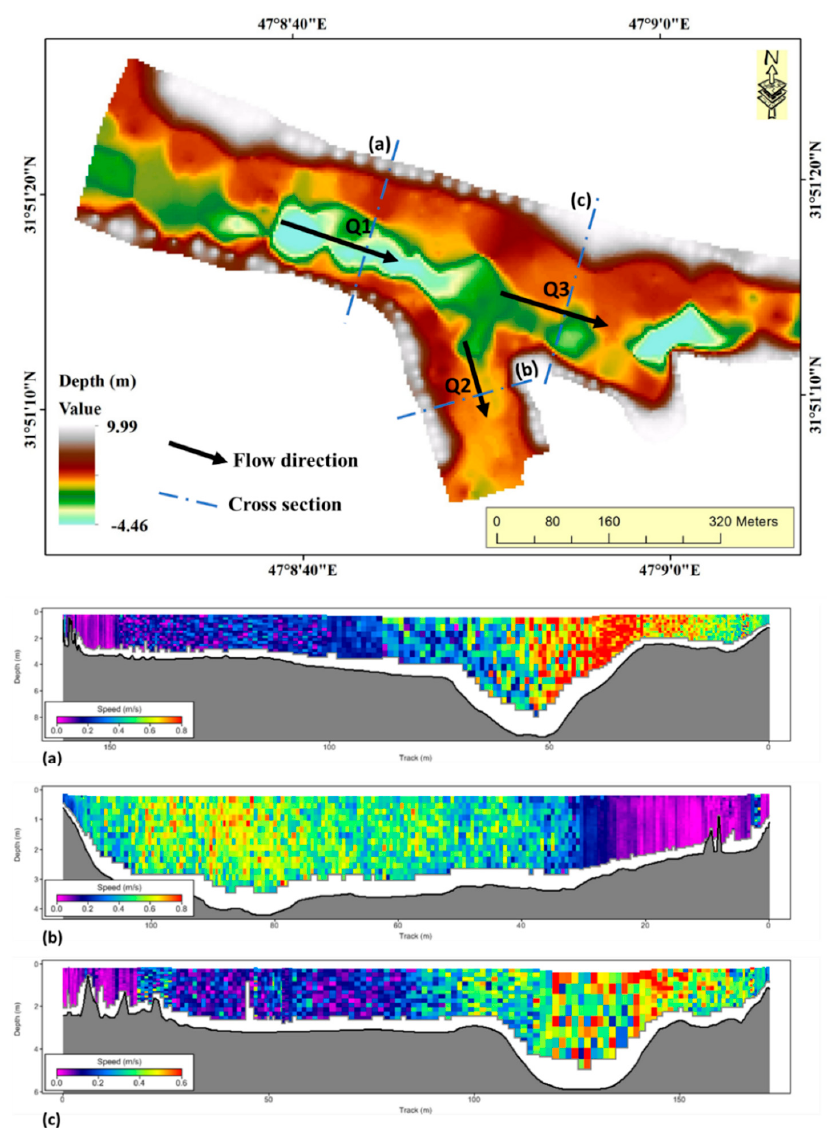
Figure 3. Observed bathymetry survey, with velocity distribution at each reach of the Tigris branching junction, ( a ) with discharge 247 m 3 /s, ( b ) with discharge 127 m 3 /s, and ( c ) with discharge 121 m 3 /s Table 2. Summary of the field data.